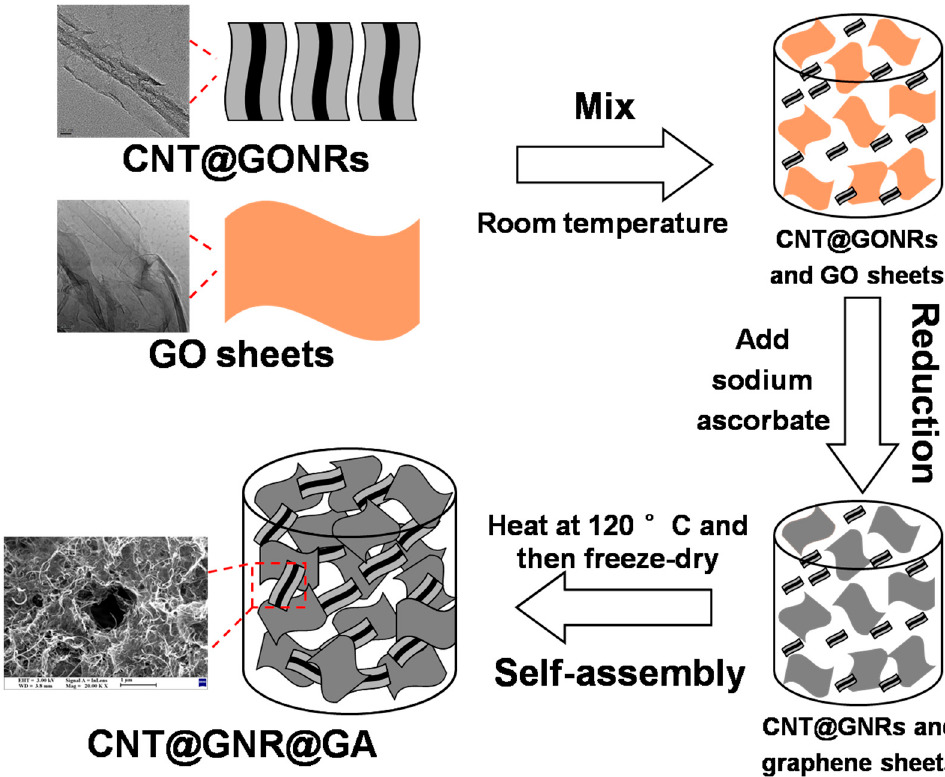
Scheme 1. Illustration of the synthetic process for CNT@GNR@GAs. For comparison, GAs were prepared via the same process without adding CNT@GONRs. Graphene/GNR aerogels (GNR/GAs) and graphene/CNT aerogels (CNT/GAs) were